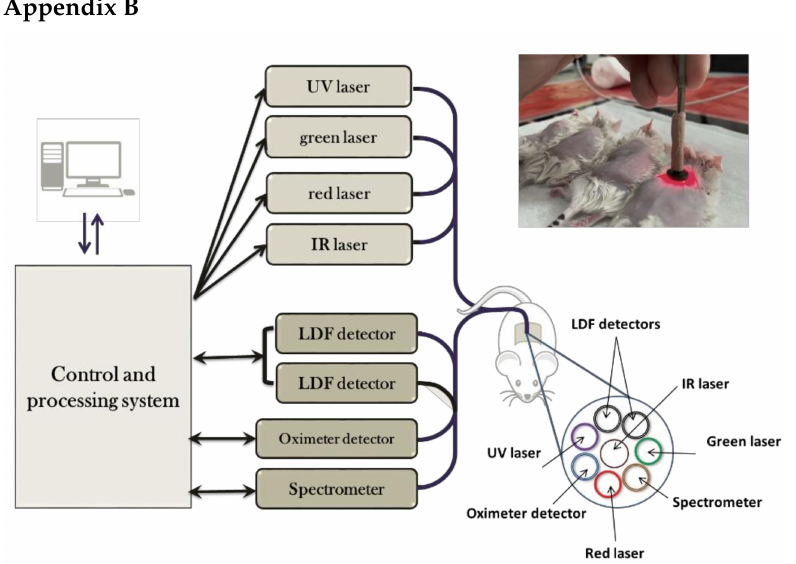
Figure A2. LAKK-M scheme and the position of the fiber-optic probe tip when measuring fluores- cence spectra.